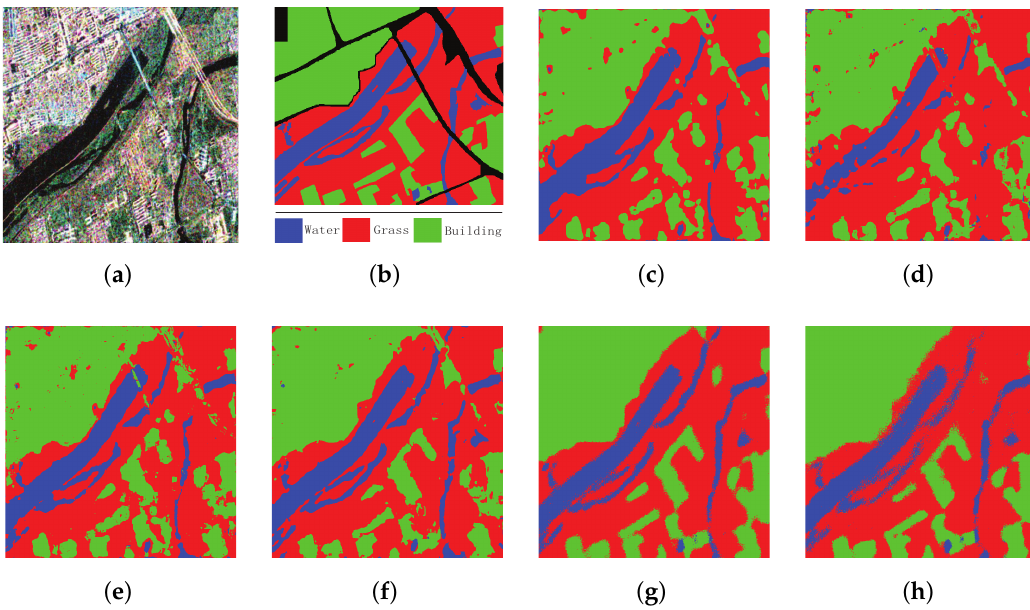
Figure 5. Classification results of Xi’an with different methods. ( a ) PauliRGB image; ( b ) ground truth map; ( c ) SVM; ( d ) SRC; ( e ) SAE; ( f ) CNN; ( g ) SFCN-128; ( h ) SFCN-256. Table 2. Classification results of Xi’an with different methods.